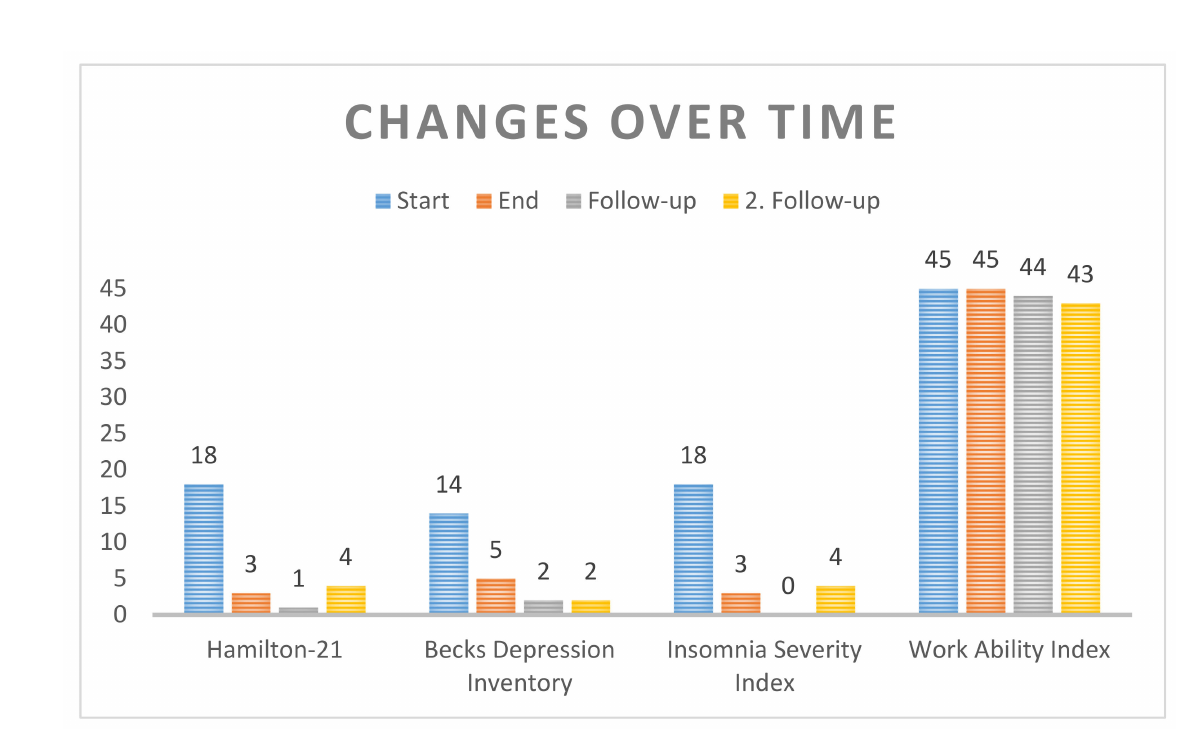
Figure 1. Changes over time. Table 3. Overview over time of